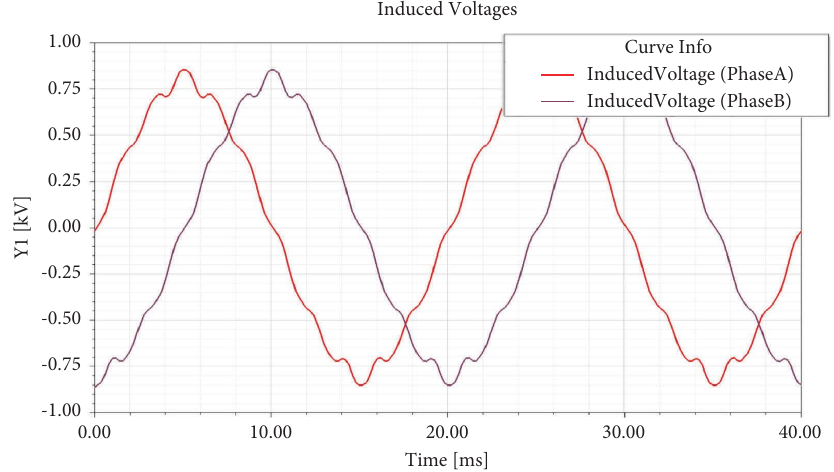
Figure 33: Back EMF curve of pea-shaped circular slot motor.